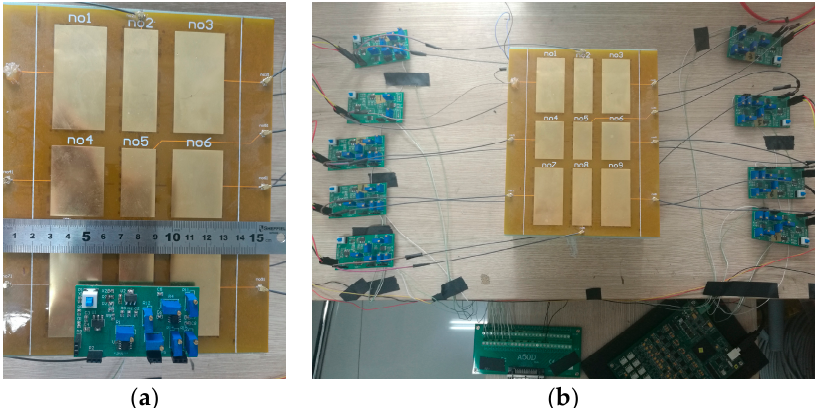
Figure 8. Detection system which includes detection panel, signal-processing board, data acquisition card: ( a ) The size of various parts of the detection system; ( b ) The location of the various parts of the detection system.